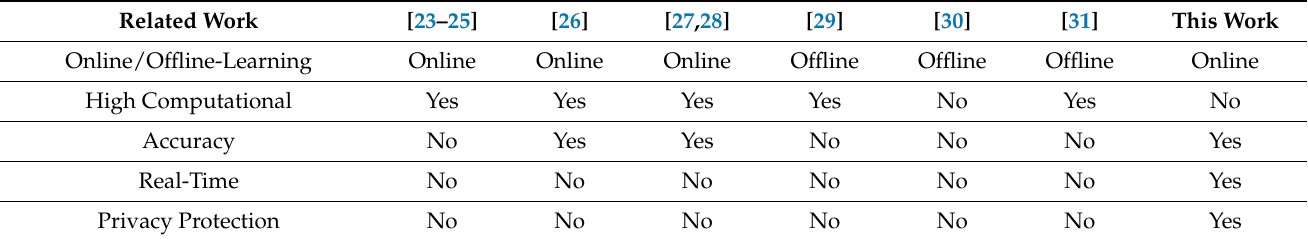
Table 1. Performance